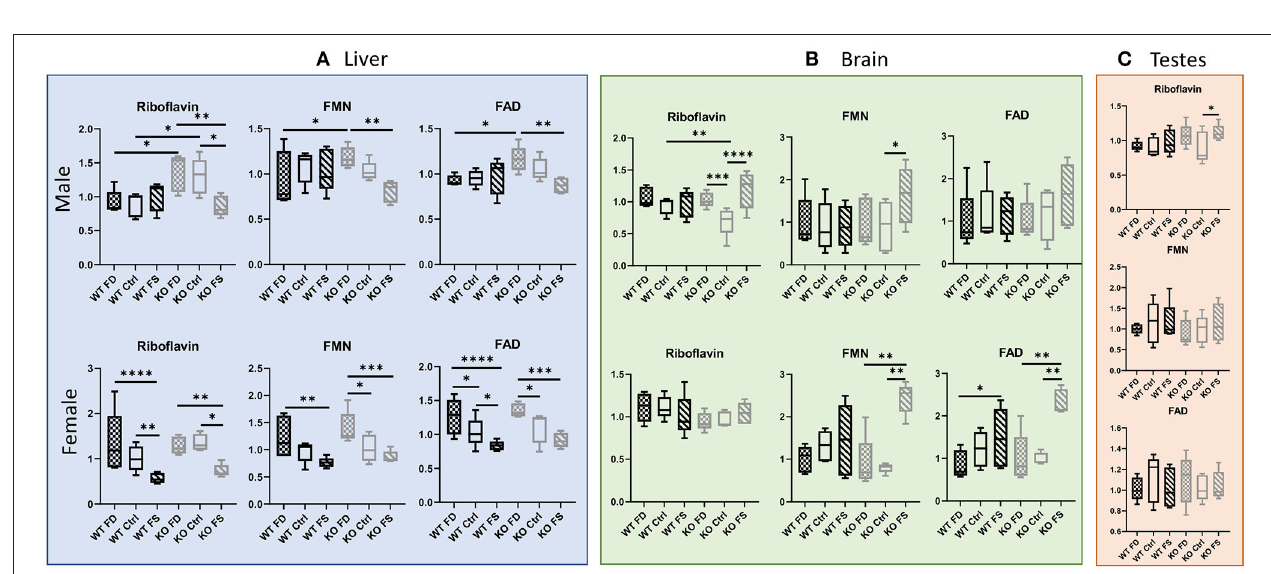
FIGURE 3 | Thiamin concentrations did not differ in livers of both sexes, while the phosphorylated forms were affected by dietary FA (A) . FA over-supplementation increased both thiamin and thiamin monophosphate in brains of KO males (B) , and no effects on thiamin metabolites were found in testes (C) . Data show minimum and maximum, with bar at median value, n = 5. Checked bars, FD diet; solid bars, Ctrl diet; striped bars, FS diet. WT is shown in black, and KO is shown in gray. * p < 0.05; ** p < 0.01; *** p < 0.001; determined by ANOVA comparisons.